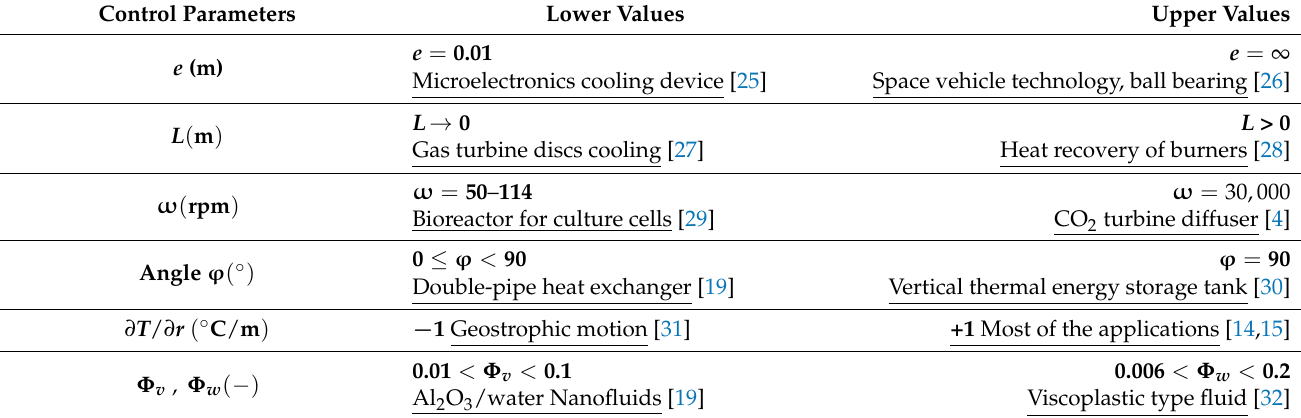
Table 1 recaps the range of values reported in various applications of the literature. Table 1. Rotating annular flow: range of applicability and literature